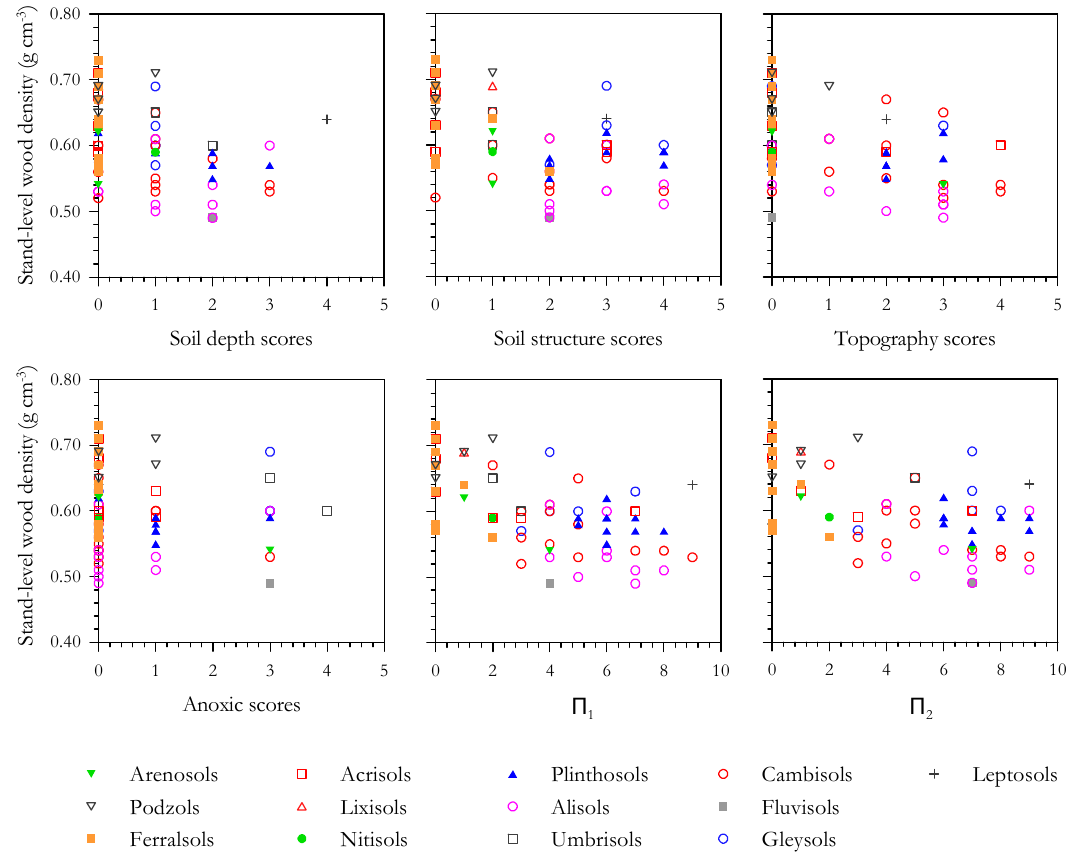
Fig. 7. Relationships between wood density and soil physical properties.For definitions of 5 1 and 5 2 see Sect. 2.2.